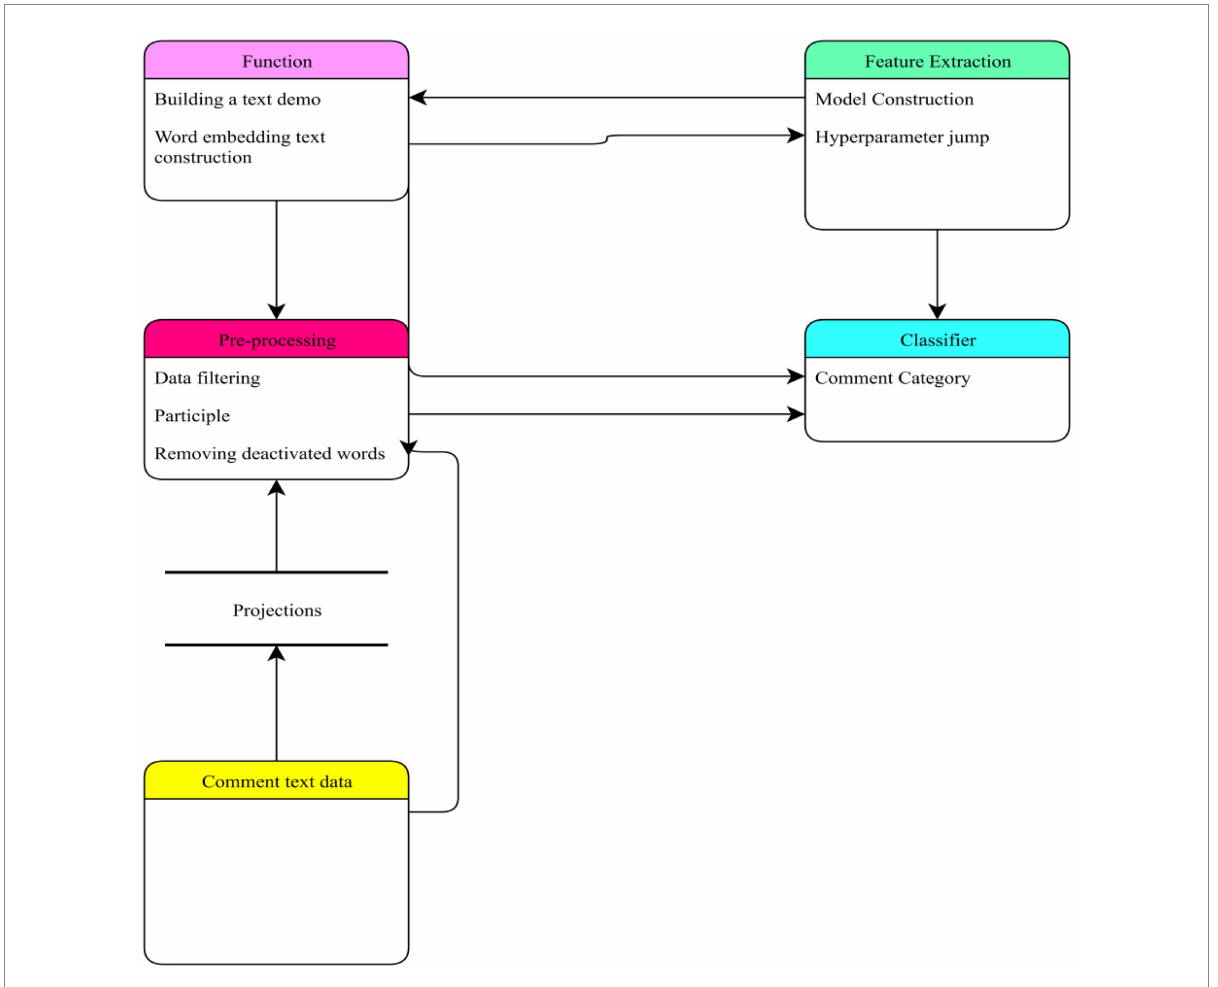
FIGURE 1 Concrete model structure of CBOW